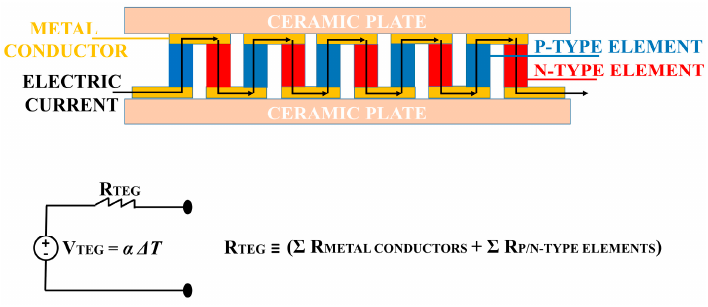
Figure 1. Structure of the TEG module and its equivalent, simplified electrical circuit.